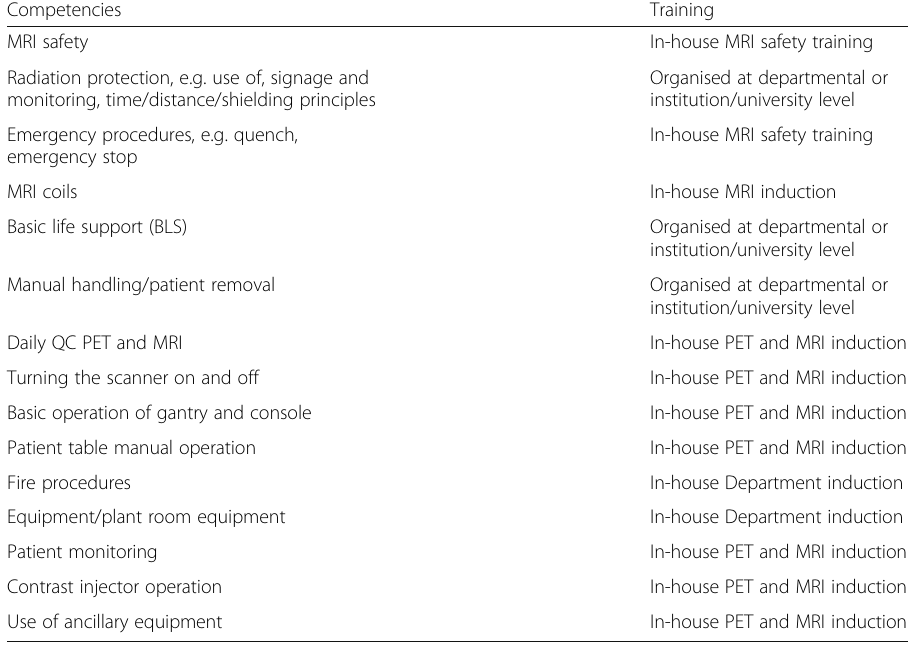
Table 3 List of competencies and training pathways Competencies MRI safety Radiation protection, e.g. use of, signage and monitoring, time/distance/shielding